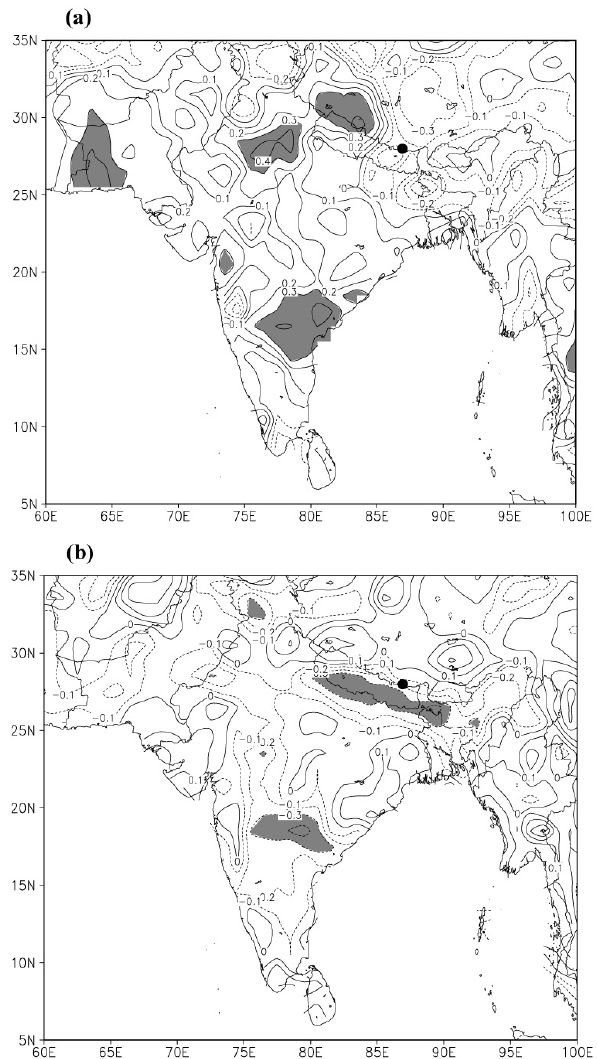
Fig. 9. Correlation coefficients of the ER accumulation rate vs. sum- mer monsoon season precipitation (a) and the ER δ 18 O record vs. the monsoonal precipitation (b) over the period of 1951–2001. Grey shading indicates correlation significance at 95% confidence level. The filled black circle indicates the ER core drilling site. Summer monsoon precipitation data are from the GPCC monthly precipita- tion data set from 1951-present with 1.0 ◦ × 1.0 ◦ resolution (avail- able at